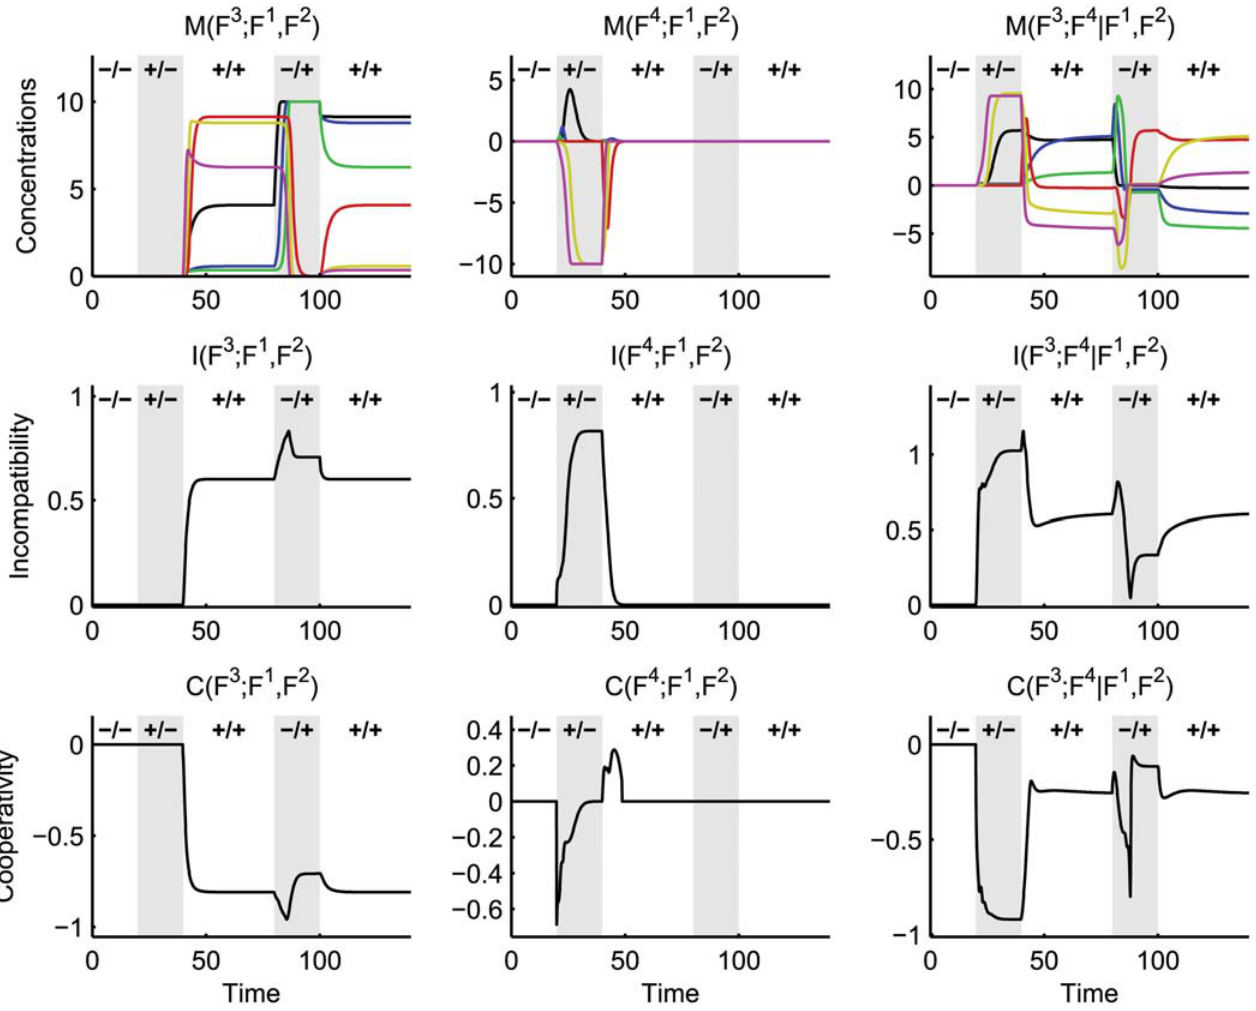
Fig 6. Mutual dynamics, incompatibilities and cooperativities between the layers of the crosstalk example. See the caption of Fig 5 for details. The first column considers the nonlinear interaction of mutual inhibition with the isolated pathways; the second column replaces mutual inhibition with mutual excitation; the third column captures the nonlinear effects of combining the inhibition and excitation crosstalk mechanisms.